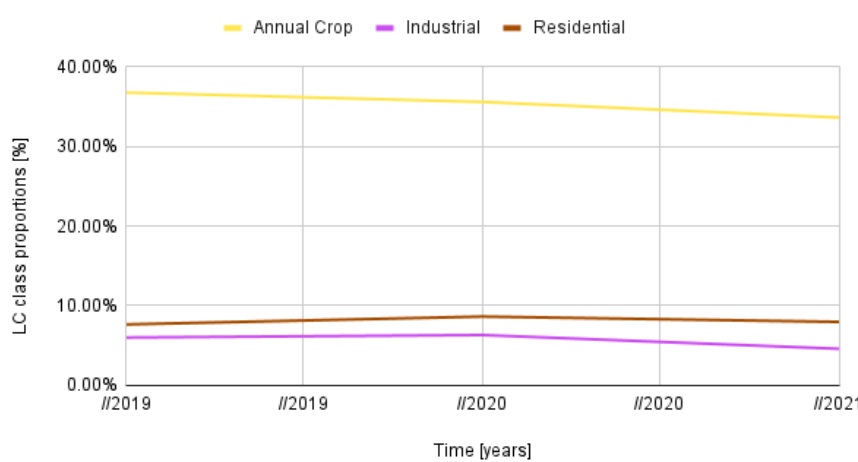
Figure 11. Annual changes of the relevant classes for